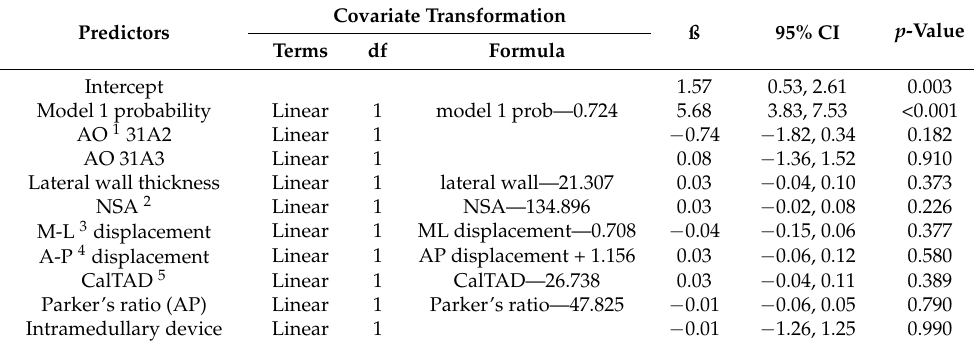
Figure 2. Comparison between area under the receiver operating characteristic (AuROC) curve of the preoperative (blue dash line) and intraoperative model (red line). Table 3. Multivariable logistic regression model after applying a multivariable fractional polynomial algorithm for predicting 1-year postoperative ambulatory status using prediction from the previous model and surgical related